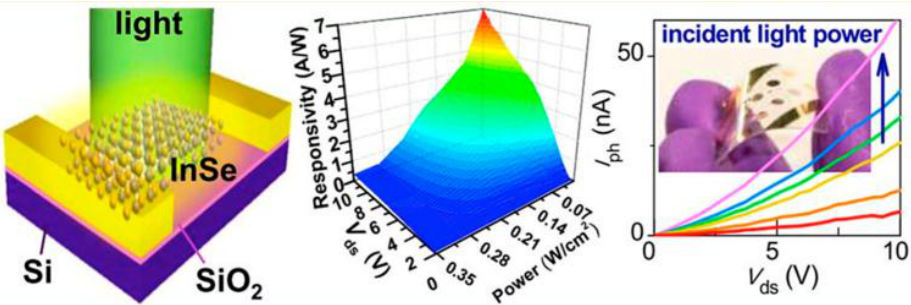
Figure 12. ( left panel ) Sketch of a InSe-based FETfor optoelectronics; ( middle panel ) Behavior of the responsivity as a function of the power and of the drain-source voltage; ( right panel ): The photocurrent of the InSe device on PET film (shown in the inset in the bent geometry) acquired when the device was in planar geometry with 633 nm illumination of 22.74, 8.67, 4.46, 2.85, 0.70, and 0.29 mW·cm −2 for purple, blue, green, yellow, orange, and red curves, respectively. Reproduced with permission from Ref. [23]. Copyright American Chemical Society, 2014.